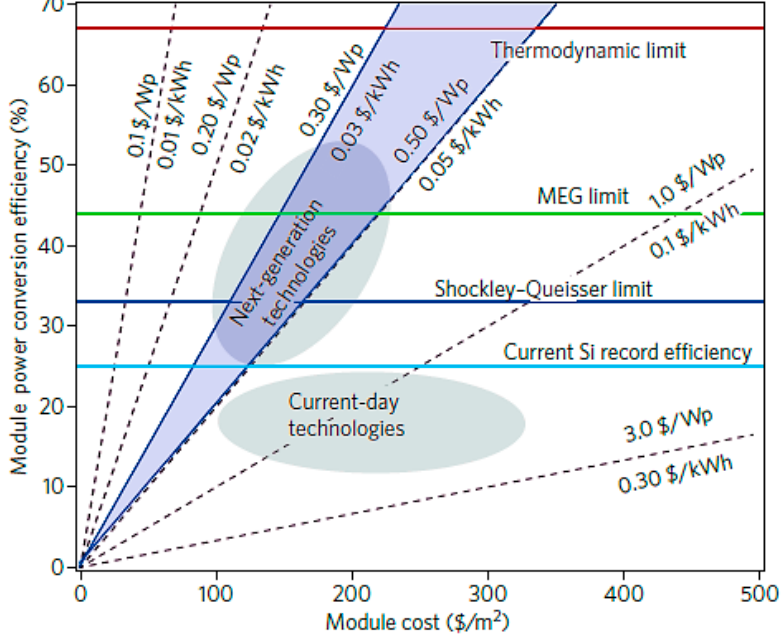
Figure 1. Relationship between power conversion efficiency, module areal costs, and cost per peak watt (in $/Wp). The light blue line represents the current laboratory record efficiency for bulk crystal silicon while the blue horizontal line is the Shockley-Queisser limit for single-junction devices. Third-generation device concepts increase the limiting efficiency (the limit for multiple exciton generation (MEG) is indicated as the green line). The thermodynamic limit at 1 sun is shown as the red line at 67% and can be reached by an infinite stack of p-n junctions. For next-generation technologies the goal is to reach 0.03–0.05 $/kWh, denoted by the blue shaded region. Adapted with permission from [12].